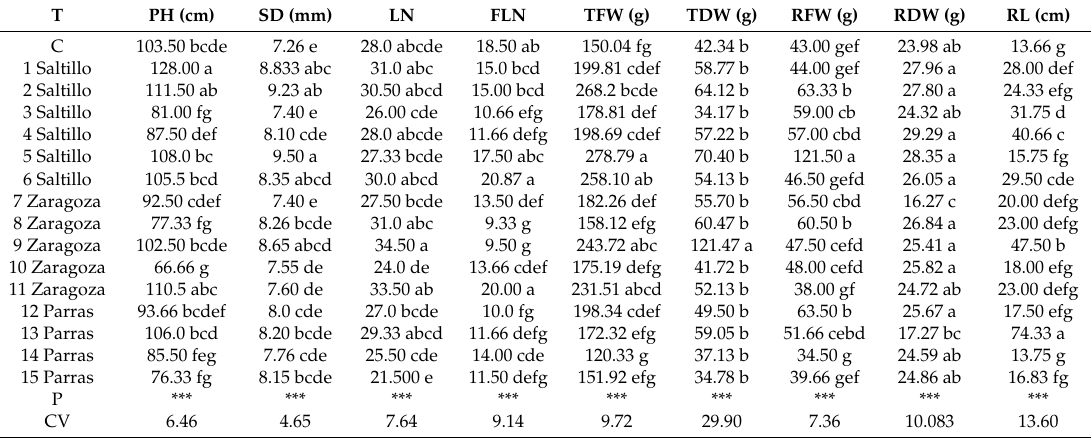
Table 5. Average effects (Tukey, p ≤ 0.05) of AMF on the agronomic parameters of greenhouse-grown cucumber.